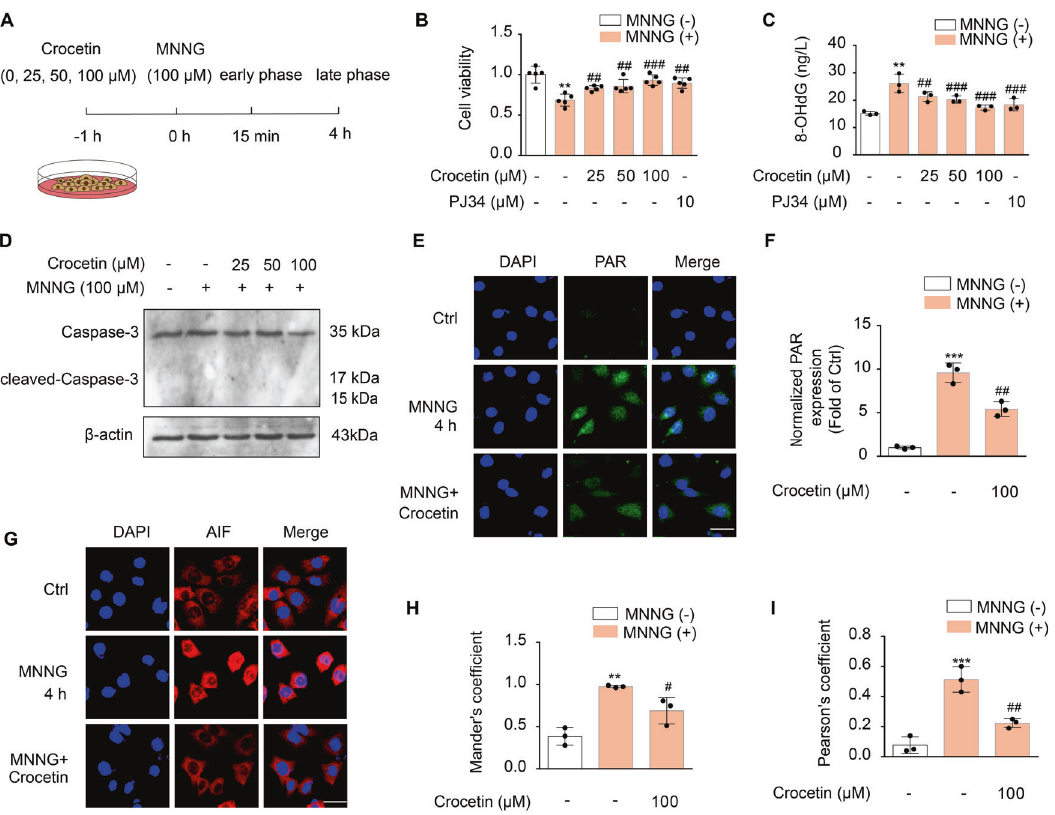
Fig. 4 Anti-pathanatos effects of crocetin at late pathanatotic phases. A Scheme diagram of the experiment. Cells were incubated with indicated concentrations of crocetin for 1 h before MNNG (100 μ M) stimulations for 15 min or 4 h. B Cell viability of SH-SY5Y cells after 4 h- MNNG determined with MTT assay. Data represent mean ± SD from fi ve independent experiments. C 4 h-MNNG-induced 8-OHdG (ng/L) in SH- SY5Y cells. Data represent means ± SD from three independent experiments. D Expression of caspase-3 and cleavage caspase-3 assessed at 4 h-MNNG. E PAR-immuno fl uorescence (green) and DAPI (blue) in SH-SY5Y cells at 4h-MNNG. Scale bars: 10 μ m. F Group quanti fi cation of E from three independent experiments. G AIF-immuno fl uorescence (red) and DAPI (blue) in SH-SY5Y cells at 4 h-MNNG. Scale bar: 10 μ m. H Colocalization coef fi cient between AIF and DAPI measured as Mander ’ s coef fi cient. I Pearson ’ s correlation coef fi cient between AIF and DAPI staining. Signi fi cance was determined by one-way ANOVA. ** p < 0.01, *** p < 0.001, vs control group; # p < 0.05, ## p < 0.01, ### p < 0.001, vs MNNG